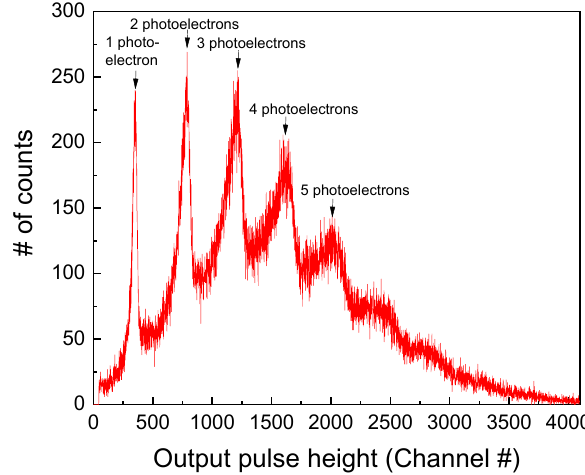
Figure 8. Output height distribution of an HPD [32]. The incident pulsed lights (wavelength = 470 nm) were adjusted to make the photocathode emit three photoelectrons on average. The cathode supply voltage and the reverse voltage were − 8 kV and 380 V, respectively.